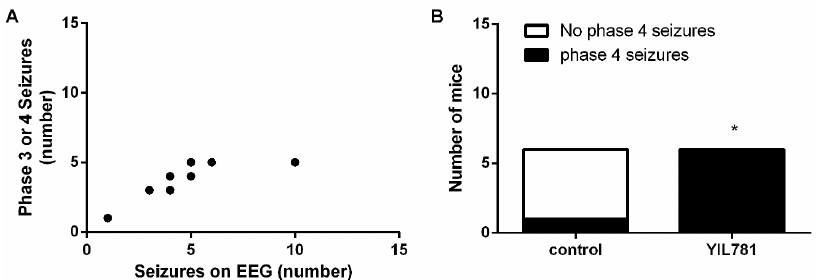
Figure 5. All YIL781-treated mice experience Phase IV seizures. ( A ) Correlation between number of Phase III and IV seizures visually observed and number of hippocampal discharges on EEG (controls and YIL781-treated mice taken together; n = 9 pairs). Pearson correlation ( p < 0.01; Pearson’s r = 0.8113). ( B ) One-hundred percent of YIL781-treated mice ( n = 6) experienced Phase IV seizures while 17% of saline-treated controls ( n = 6) did. Fisher’s exact test ( p < 0.05). * p < 0.05; EEG, electro-encephalography.